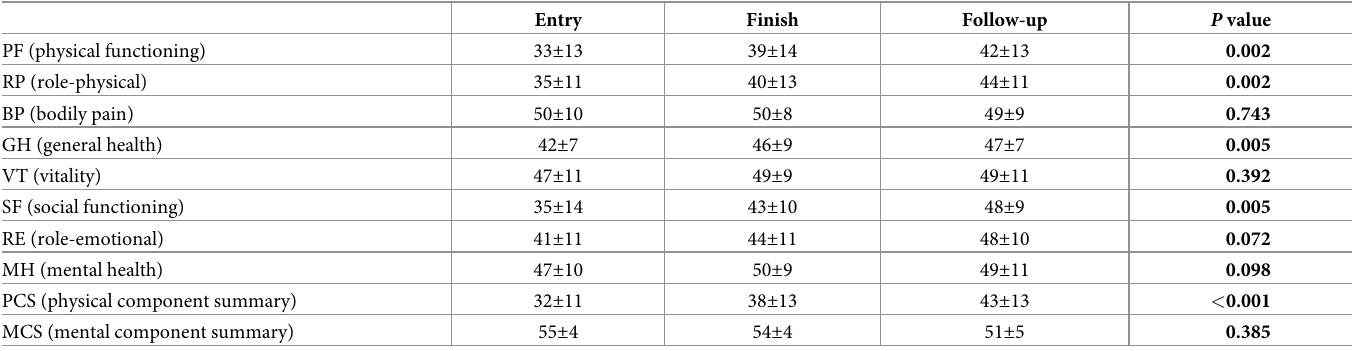
Table 5. Trend of SF-36